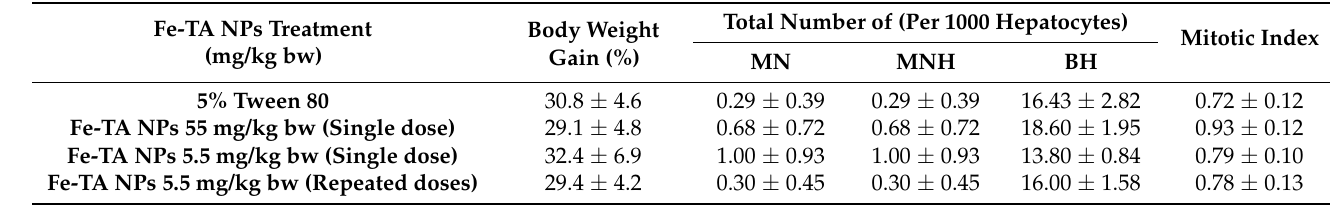
Table 4. Effect of Fe-TA NPs on micronucleus formation in rat